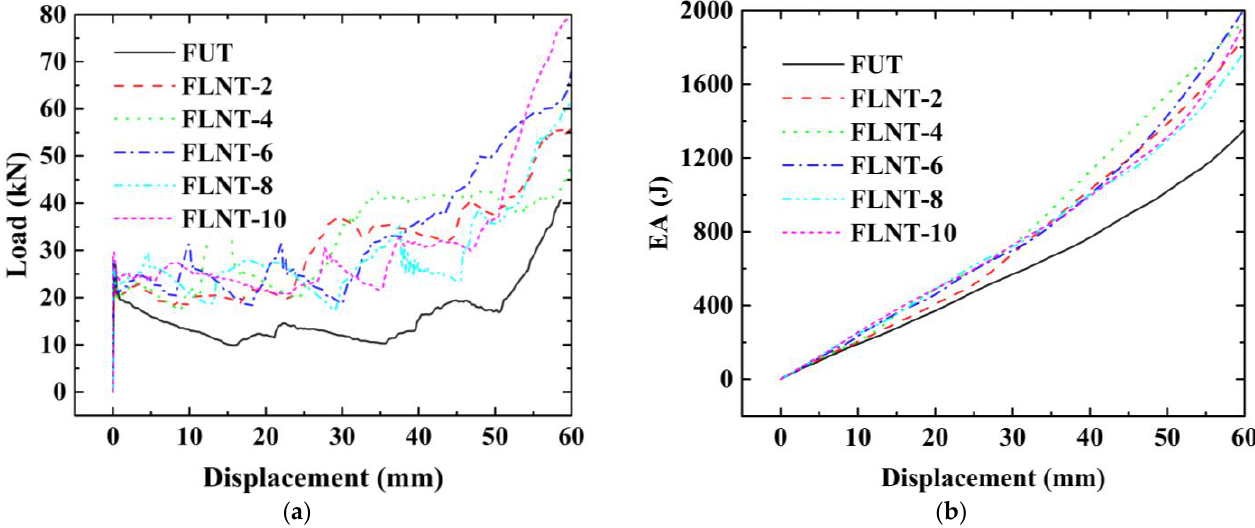
Figure 15. Effect of stripe number for filled tubes: ( a ) load – displacement relations and ( b ) energy – displacement relations.